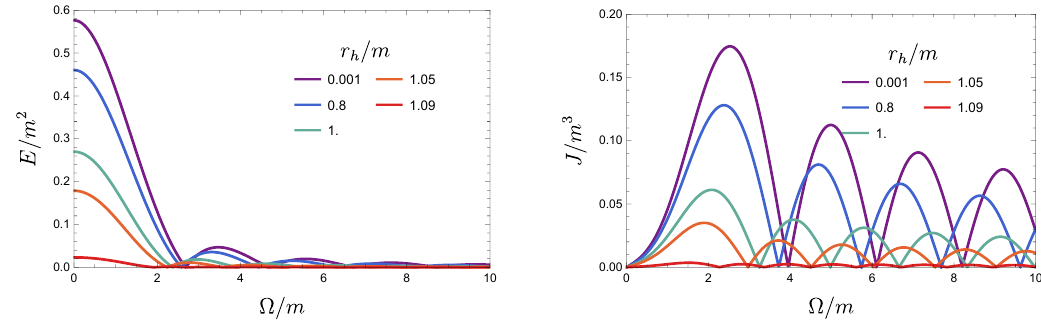
Figure 14 . Electric field and current of the critical embeddings versus driving frequency, for different values of r h in the D3/D7 system. The structure is mainly the same as the one found for the D3/D5 case. Here the maximum temperature for the Minkowski embeddings is slightly higher, while the height of the lobes is suppressed faster as one increases the driving frequency.